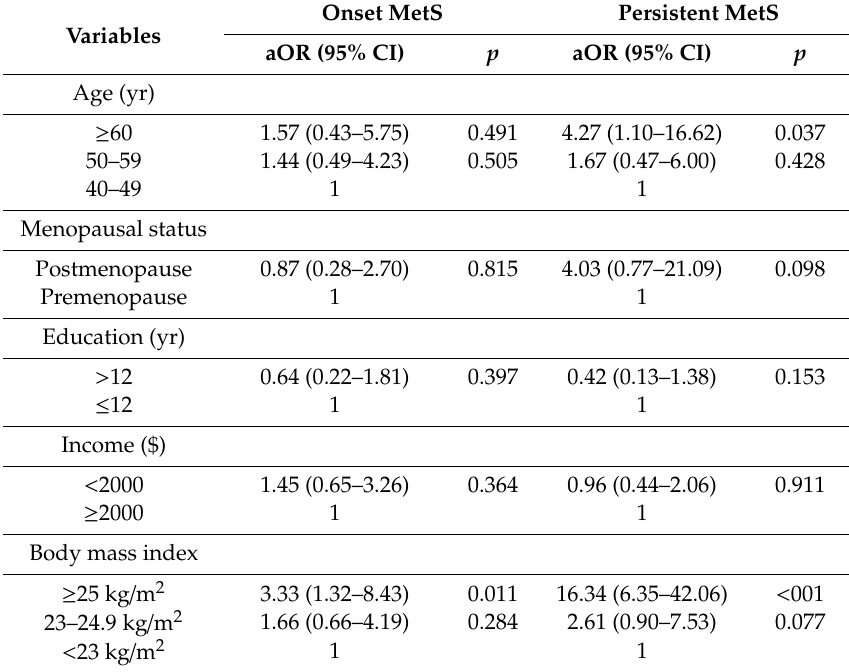
Table 3. Multivariate odds ratios for metabolic syndrome in breast cancer